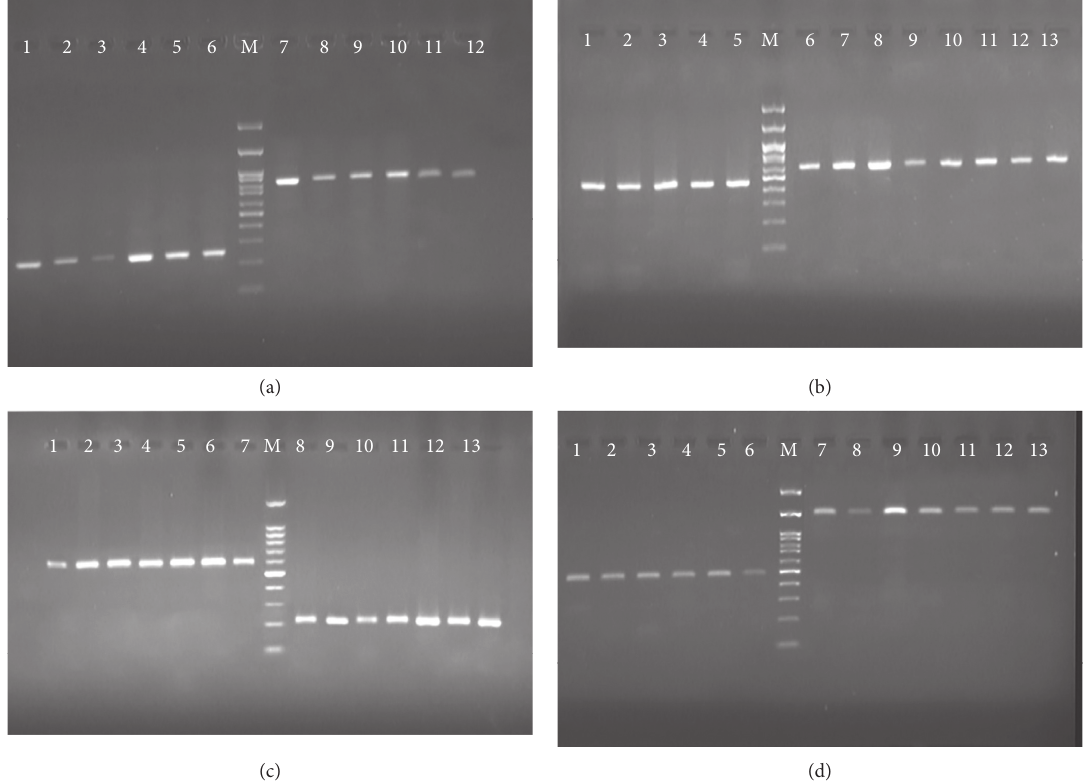
Figure 2: The amplification result of iron/siderophore mediate gene in A. baumannii . (a) basD gene with 868bp and bauA gene with 224bp; well 1: positive control; wells 2 to 7: positive strains with basD gene; well 11: positive control; wells 8 to 10: positive strains with bauA gene. (b) pld gene with 662bp and paaE gene with 593p; well 1: positive control; well 3 to 10: positive strains with paaE ; well 13: positive control; wells 7 to 12: positive strains with pld . (c) feoB gene with 636bp and hemO gene with 215bp; wells 1: positive control; wells 2 to 5: positive strains with hemO ; wells 10: positive control; wells 6 to 9: positive strains with pld . (d) entA gene with 504bp; wells 1: positive control; wells 2 to 9: positive strains with tonB gene. (M) Ladder